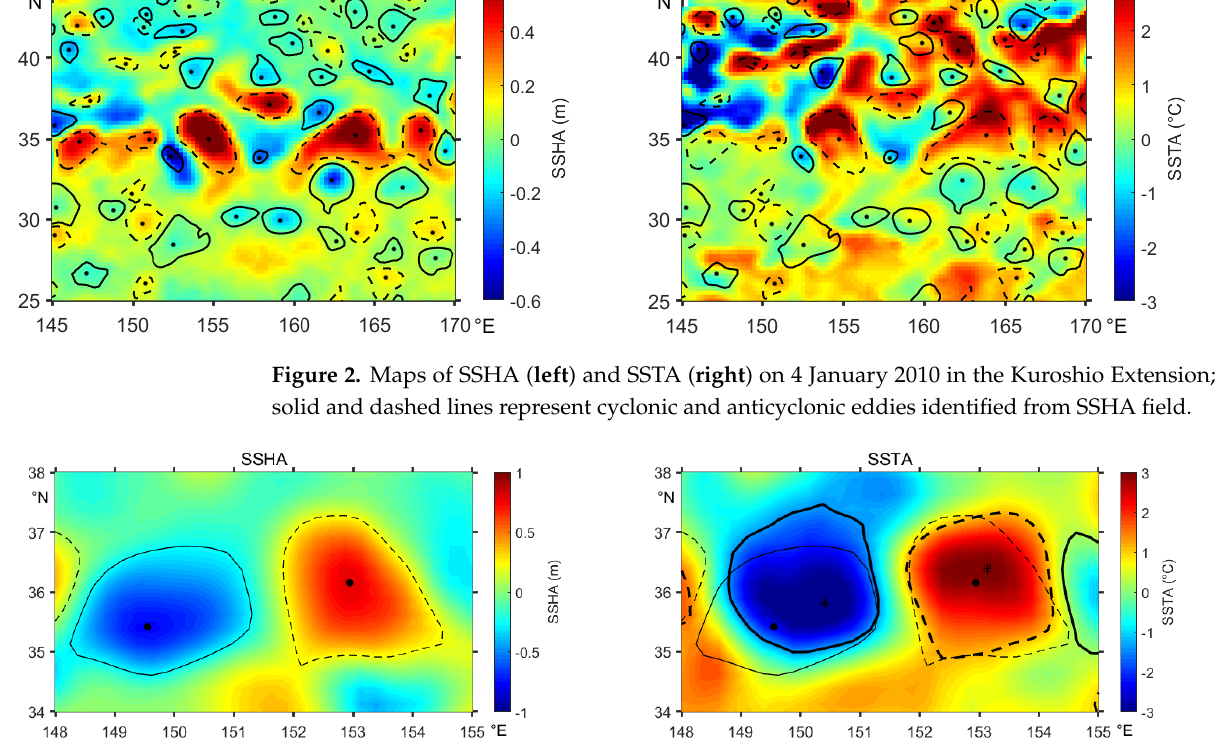
Figure 3. SSHA-based eddy result ( left , the thin lines) and SSTA-based eddy result ( right , the thick lines) in the Kuroshio Extension; the solid and dashed lines represent cyclonic and anticyclonic eddies. In the right panel, the SSHA-based eddies are drawn with thin lines as a comparison with SSTA-based eddies.